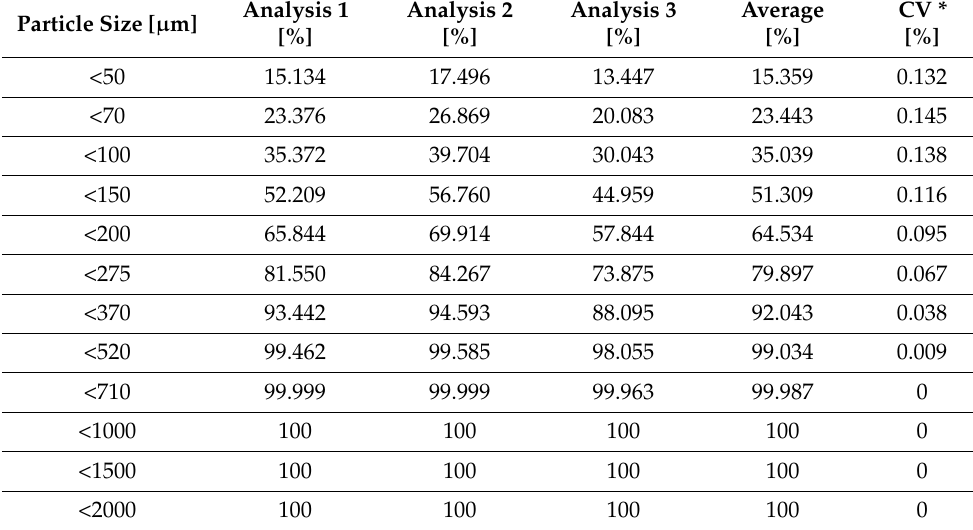
Table 7. The average particle size distribution analysis in terms of cumulative frequency. Particle Size [ µ